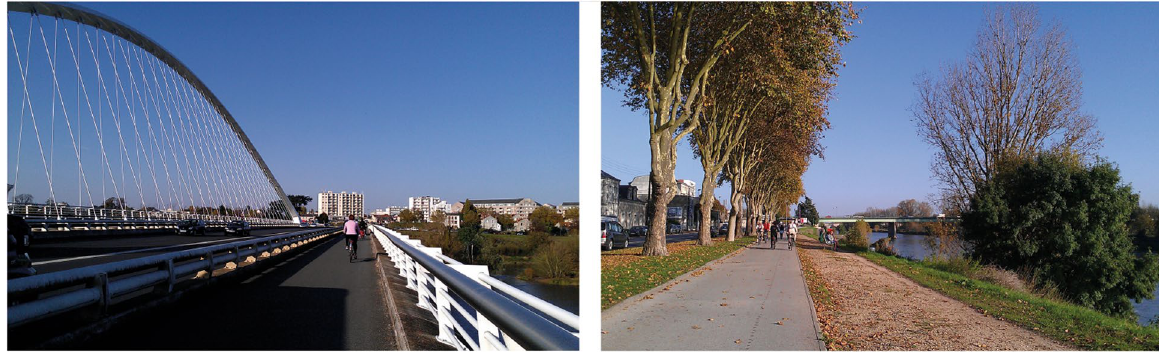
Fig. 9 Cycleway along the Loire, Orléans, 2014 (Source: Liang